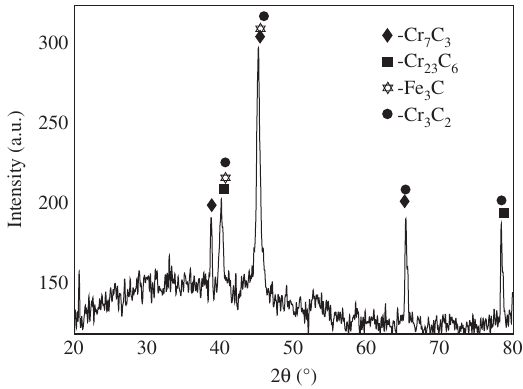
Figure 2 The XRD pattern for FeCrC alloy cladding.